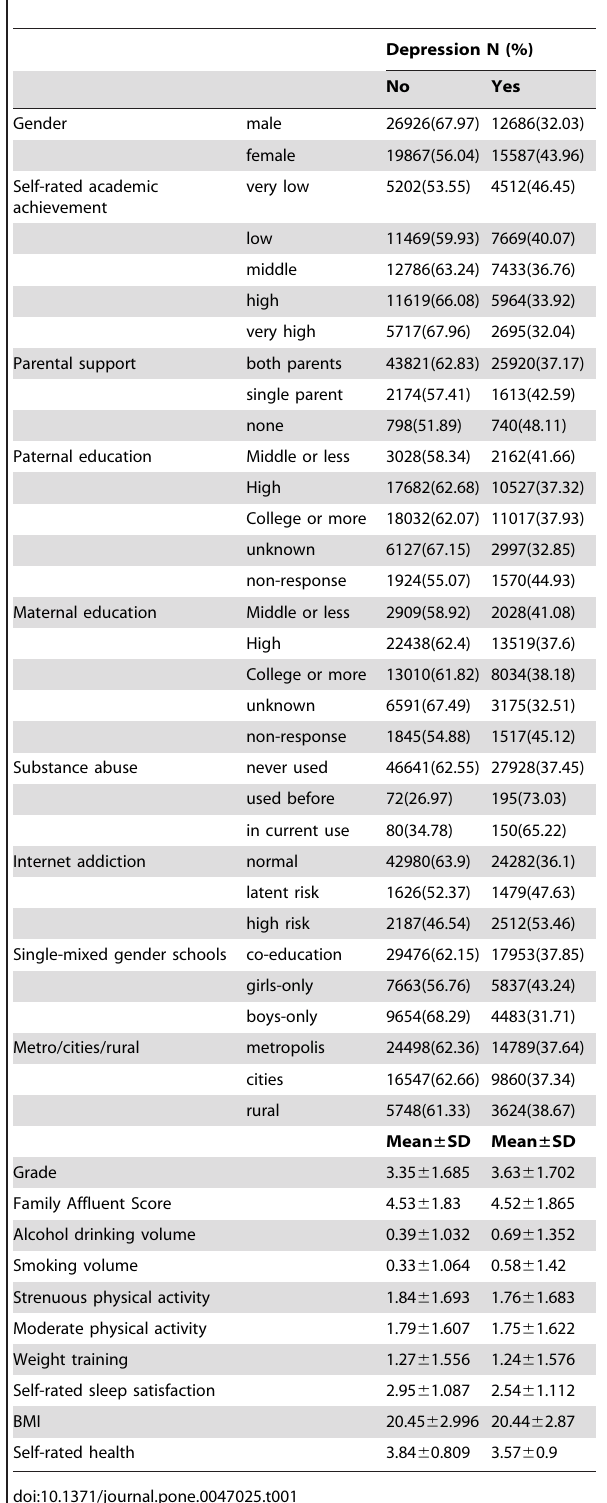
Table 1. Characteristics of study subjects by ‘depression’